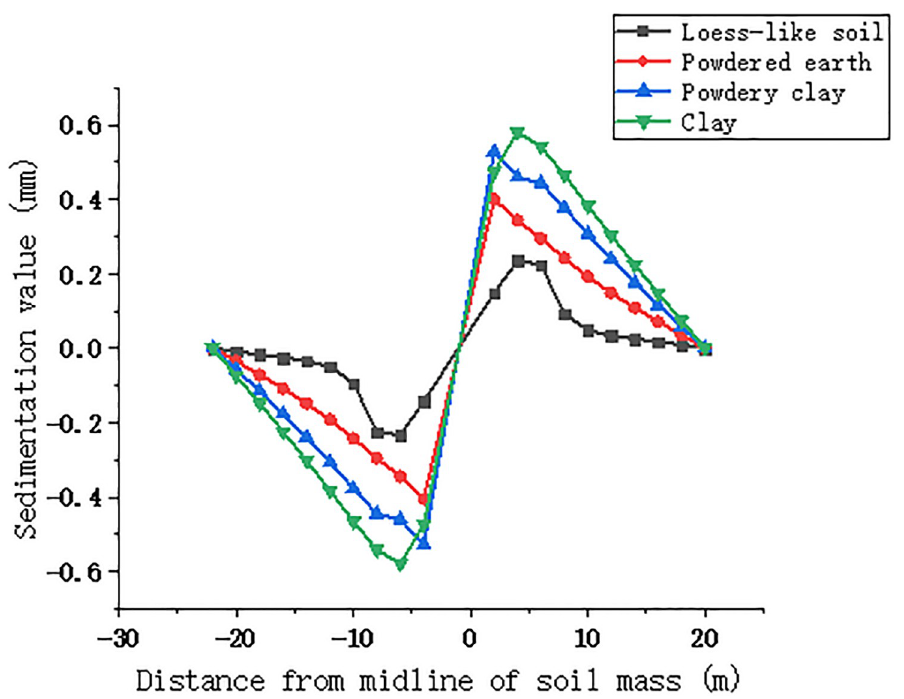
Fig 19. Transverse deformation curves of four soil surfaces jacked up to 5m.